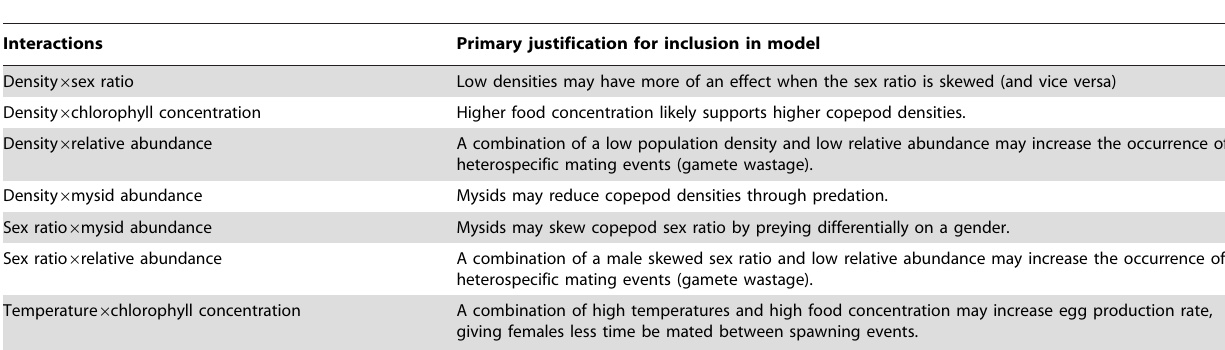
Table 1. Description of a priori selected interaction terms included in generalized linear mixed models assessing the effect of ecological and environmental parameters on Temora longicornis and Eurytemora herdmani fertilization success.